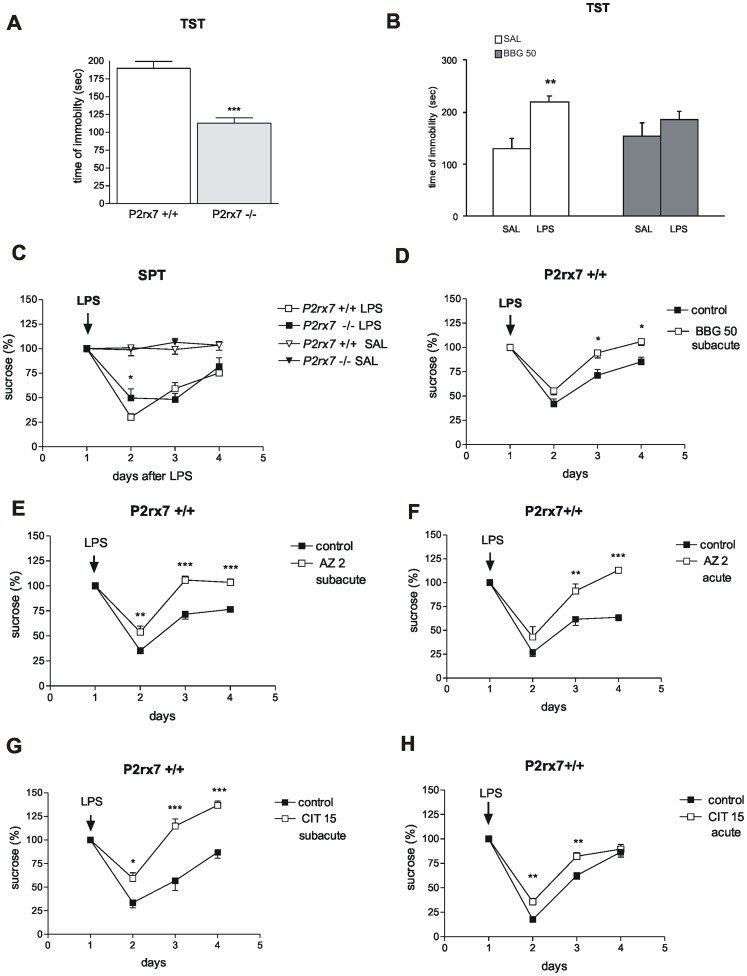
Genetic deletion and pharmacological inhibition of P2rx7 results in antidepressant phenotype in mice using the TST (A, B) and SPT (C–H) tests.A/Genetic disruption of P2rx7 expression decreases basal immobility in the TST (n = 6,10, ***P<0.001 vs. P2rx7+/+, Student t test). The immobility time is expressed in sec. The total test period was 360 sec. B/Effect of acute BBG treatment (50 mg/kg i.p.) on LPS-induced depressive behavior in TST. LPS was added at a dose of 1 mg/kg at 24 h before testing (n = 7–9, **P<0.01 vs. SAL, Student t test). BBG was administered intraperitoneally at 30 min before testing; saline-treated mice (SAL) were injected with equal volume of saline. C/LPS-induced decline in sucrose preference is attenuated in P2rx7−/− mice. Baseline sucrose intake was measured under a habituation period of 3–4 days before treatment, and the mean volume ingested over the last 3 training sessions was used as a baseline value. The mice were treated with LPS (0.2 mg/kg i.p.) or an equal volume of saline (SAL), indicated by an arrow, and the sucrose intake was monitored over subsequent days. LPS substantially decreased sucrose consumption as a sign of anhedonia (FLPS(1, 63) = 1193; P<0.0001). The sucrose consumption was expressed as a percentage of the baseline (%). N = 9–14, *P<0.05 vs. P2rx7+/+. Two-way ANOVA, followed by Fischer LSD test. D-H/The P2X7 receptor antagonists Brilliant blue G (BBG), AZ-10606120 (AZ), and the selective 5-HT re-uptake inhibitor citalopram (CIT) inhibit the development of LPS-induced anhedonia in P2rx7+/+ mice. D/The antidepressant effect of a subacute, 4-day treatment with BBG (50 mg/kg i.p./day, n = 8–20, *P<0.05, vs. control). E/The effect of subacute (AZ 2 subacute) AZ-10606120 treatment on LPS-induced anhedonia. Notably, in this protocol, AZ-10606120 significantly attenuated the decline in sucrose consumption at 24 h after LPS treatment. (FAZ (1,39) = 1179.4, P<0.00001; n = 5–9, **P<0.01, ***P<0.001 vs. control). F/The effect of acute AZ-10606120 (AZ 2, acute) treatment on LPS-induced anhedonia. When mice were pretreated with AZ-10606120 for 30 min before LPS injection at the doses indicated in the legend (mg/kg), sucrose consumption on the 2nd and 3rd day after LPS injection was significantly higher (n = 7–8, **P<0.01, ***P<0.001 vs. control). G and H/. Effect of 4-day subacute (CIT 15 subacute, G), and single acute treatment with citalopram (CIT 15, acute, H) on LPS-induced anhedonia. Citalopram elicited a comparable effect to AZ-10606120 using both application protocols (n = 5–10, **P<0.01, ***P<0.001 vs. control). The sucrose consumption in all experiments was evaluated at 0, 24, 48 and 72 h after LPS injection and expressed as a percentage of the baseline. Two-way ANOVA, followed by Fischer LSD test was performed as statistical analyses in SPT datasets. 2–3 months old drug- and test-naive male homozygous mice (P2rx7+/+ and P2rx7−/−), weighing approximately 30 g were used in the experiments.